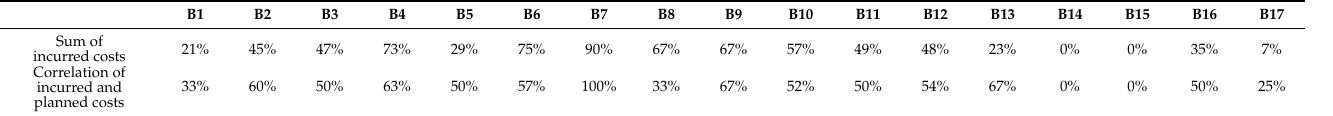
Figure 3. Incurred and planned costs. Table 2. The percentage of incurred costs and the correlations of incurred and planned costs.